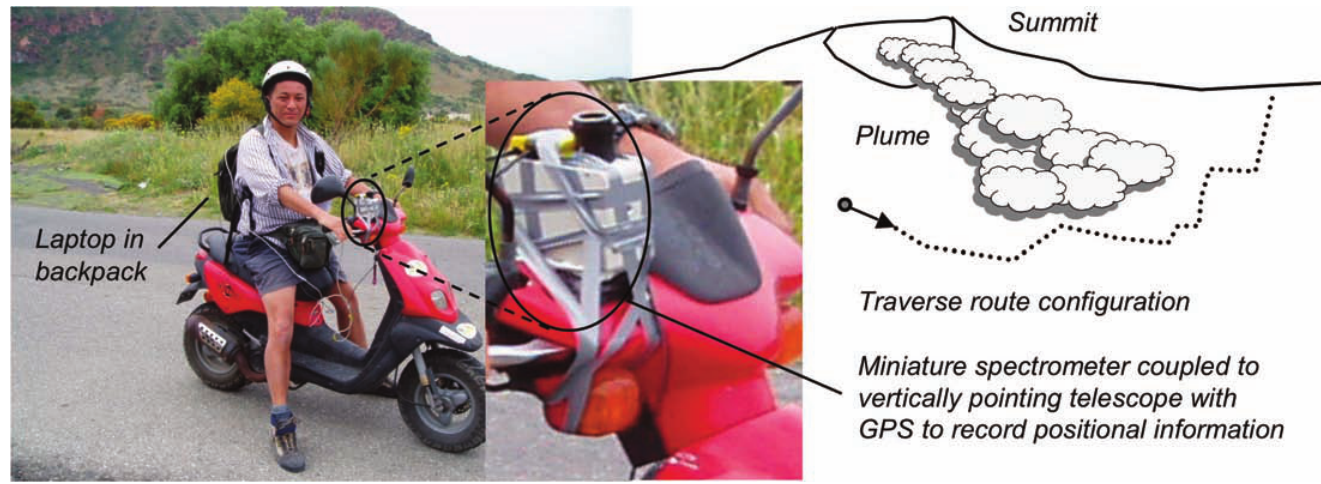
Figure 1. Left – SO flux measurements performed via motorcycle traverses on roads downwind of La Fossa crater, Vulcano. Inset – Instrumentation used: 2 laptop-computer-controlled miniature (USB2000) UV spectrometer, coupled to a vertically pointing telescope, and a GPS unit for geo-referencing. Right – Schematic drawing of traverse route beneath the volcanic plume. Gas fluxes are obtained by integrating the recorded SO plume cross-section, then multiplying by the plume transport